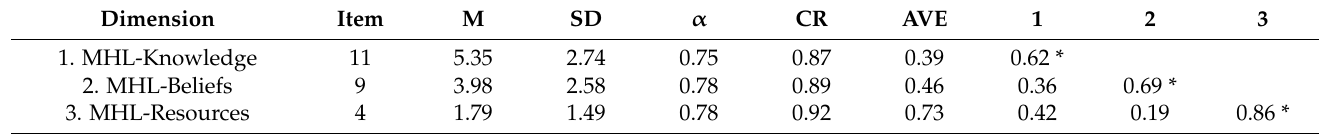
Table 2. Convergent validity, discriminant validity, and reliability.